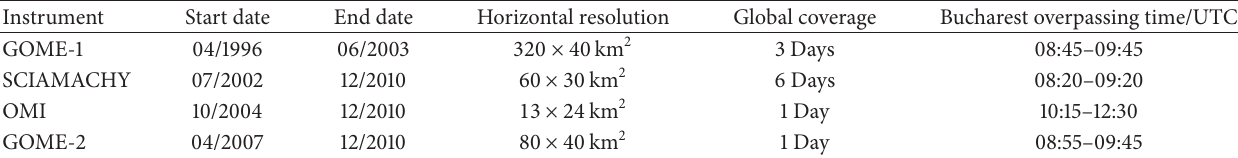
Table 1: Instruments aboard satellites used in the analysis.